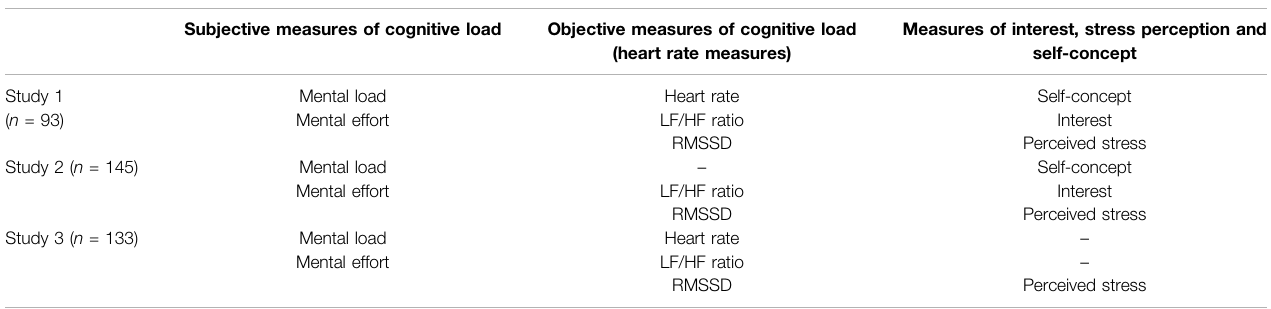
TABLE 2 | Assessments in the three